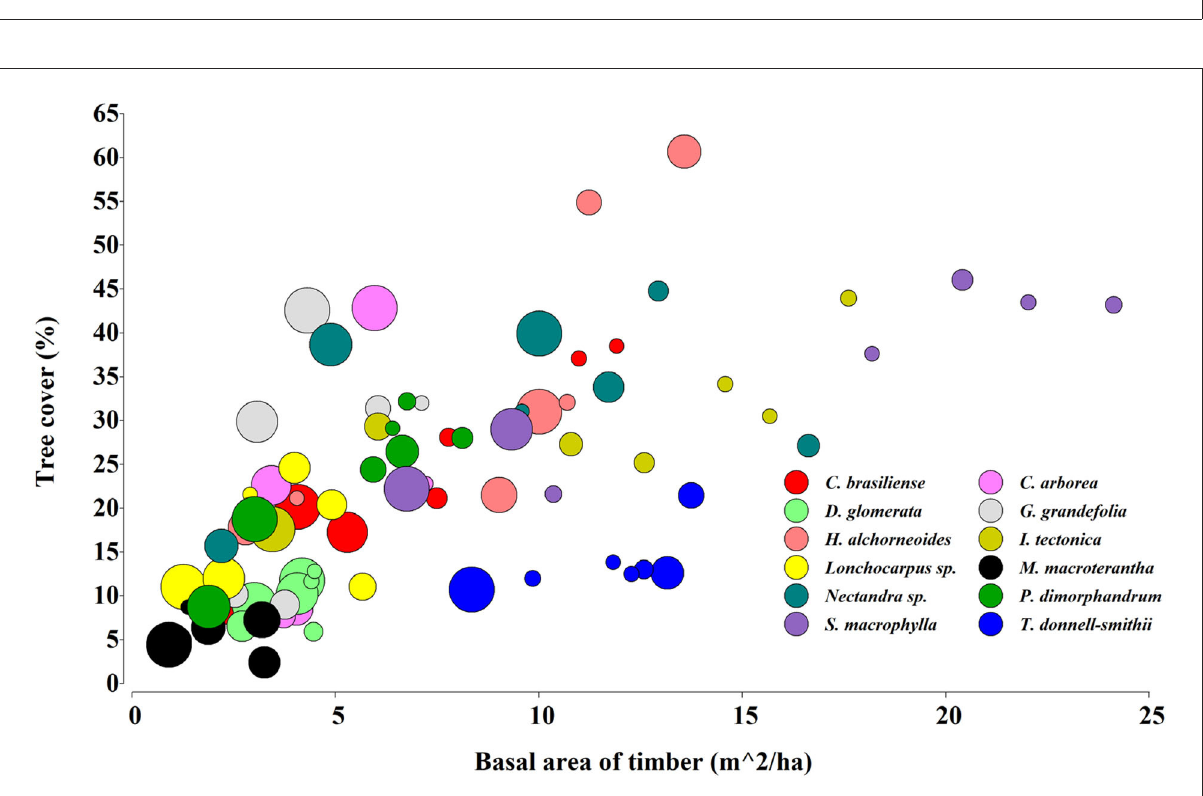
FIGURE7 Combined effects of tree cover (%) and timber basal area (m 2 ha − 1 ) on cacao yields (the larger the circle size the greater the yields) of 12 timber-based agroforestry systems in the experimental site “CEDEC-JAS”, La Masica, Atlántida,